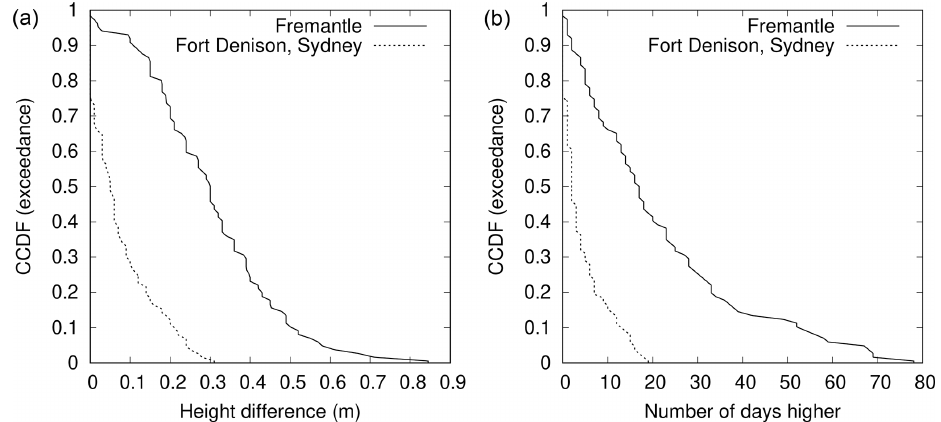
Figure 9. Complementary cumulative distribution functions (CCDFs) for Fremantle and Fort Denison (Sydney). (a) Annual first metric , which is height of highest observed sea level above observed maximum on day of highest predicted tide for the year, for daylight days ( o d (I od (j,k),j,k) − o d (I pd (j,k),j,k) ), estimated over all valid years, j . (b) Annual second metric , which is no. of days when observed sea level, o d (i,j,k) , higher than observed maximum on day of highest predicted tide for the year, o d (I pd (j,k),j,k) , for daylight days , estimated over all valid years, j .